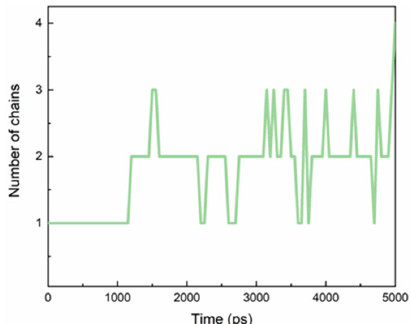
Figure 2. The evolution of the average number of TEGPy arms that nestled in grooves of the ILPR G4.